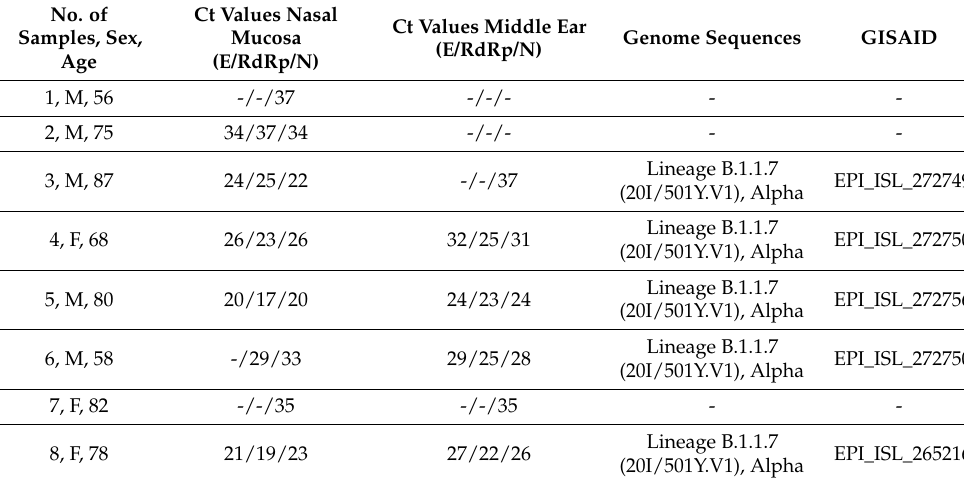
Table 1. Results of virology